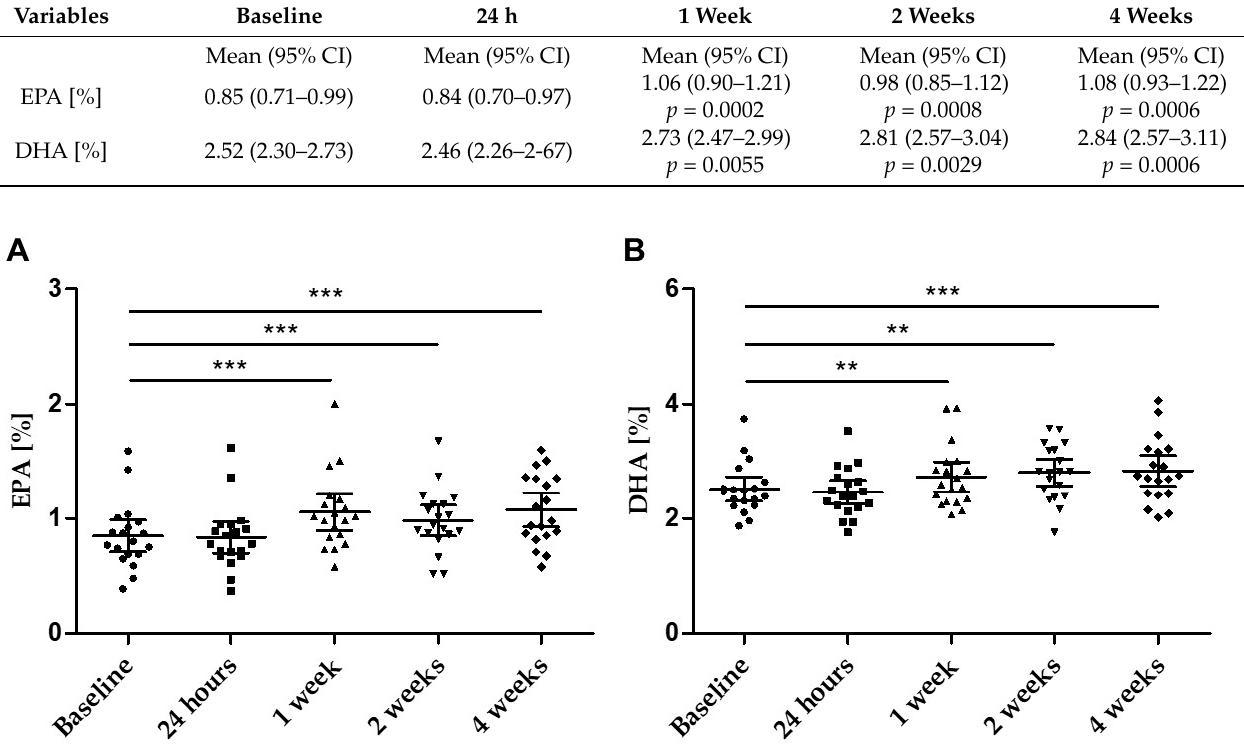
Figure 5. Concentration of ( A ) EPA (%) and ( B ) DHA (%) in plasma over the four weeks of supple- mentation at defined time points; scatter plot n = 19 with mean ± 95% CI; ** p < 0.01; *** p < 0.001